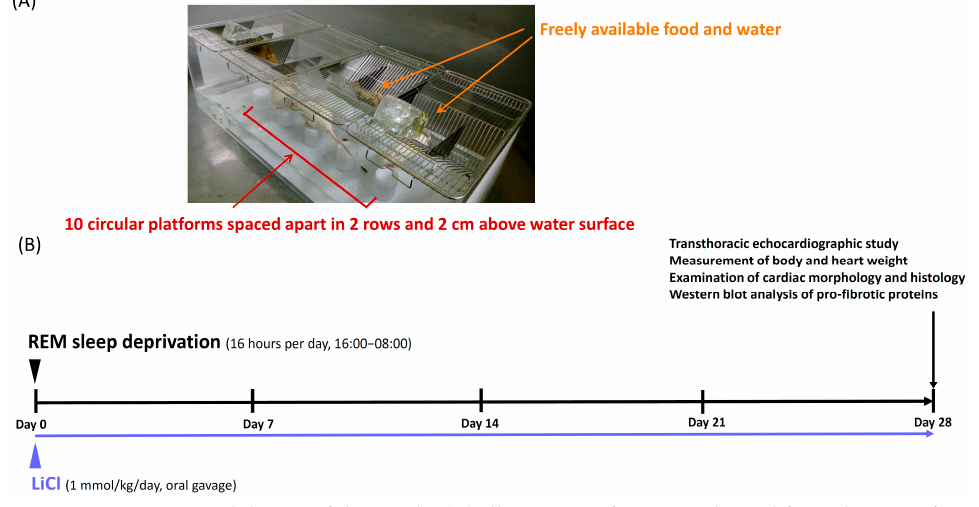
Figure 7. Experimental design of this study. ( A ) Illustration of water tank used for induction of REM sleep deprivation in male Wistar rats. ( B ) Illustration summarizes the experimental protocol. The rats in the REM sleep deprivation group were subjected to REM sleep deprivation for 16 h per day (16:00 − 08:00) over 4 weeks. For the group with lithium treatment, LiCl at a dosage of 1 mmol/kg was administered by oral gavage once a day for 4 weeks.